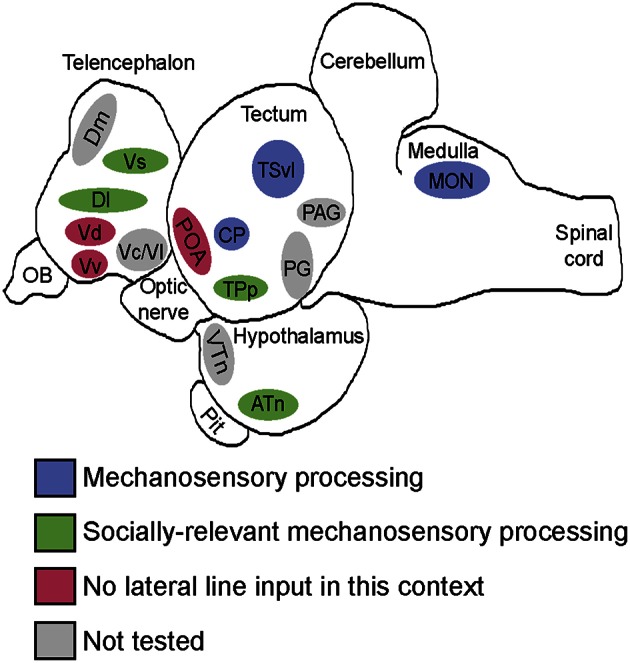
Summary schematic of socially-relevant mechanosensory processing in the cichlid brain. Blue represents mechanosensory processing regions. Green represents nuclei of the SDMN that receive lateral line input and possibly use it to modify behavioral output. Pink represents SDMN nuclei without evidence for mechanosensory input during aggressive contexts. Gray represents SDMN and sensory processing regions not tested for a potential role in processing socially-relevant mechanosensory signals. Locations of nuclei on the sagittal brain outline are only approximate. See list for abbreviations.